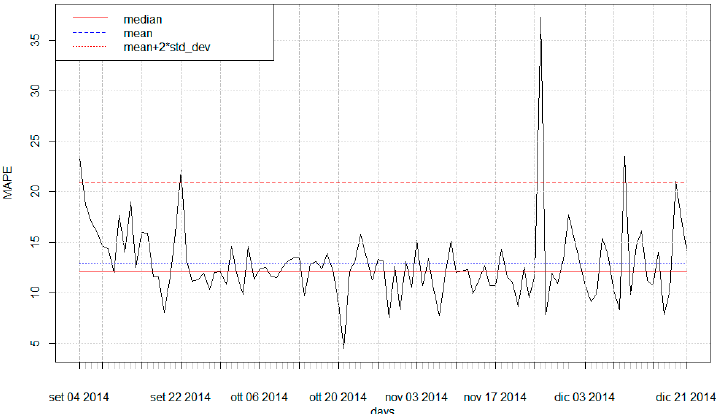
Figure 11. MAPE over the observation period for the residential case (Case 1).